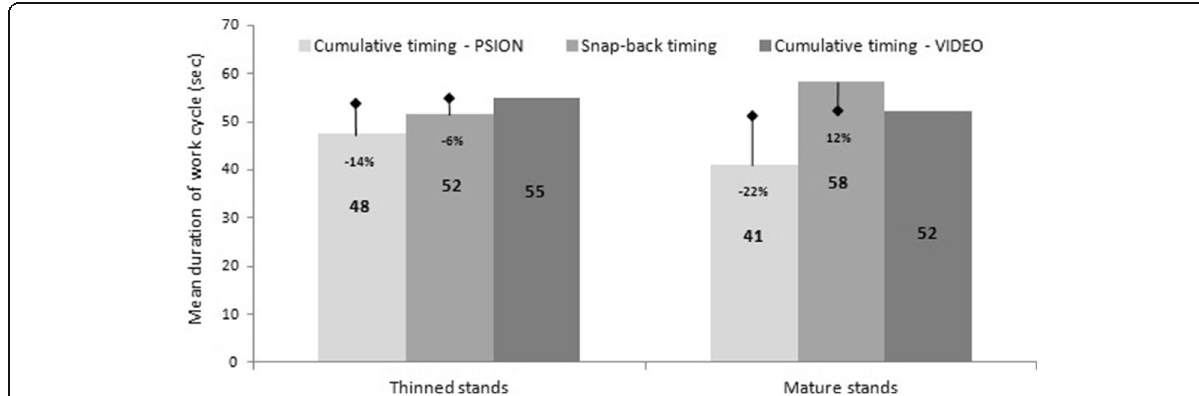
Fig. 6 Percentage value of the measurement error and the mean duration of a work cycle in the investigated calculation methods, in relation to the cumulative timing VIDEO